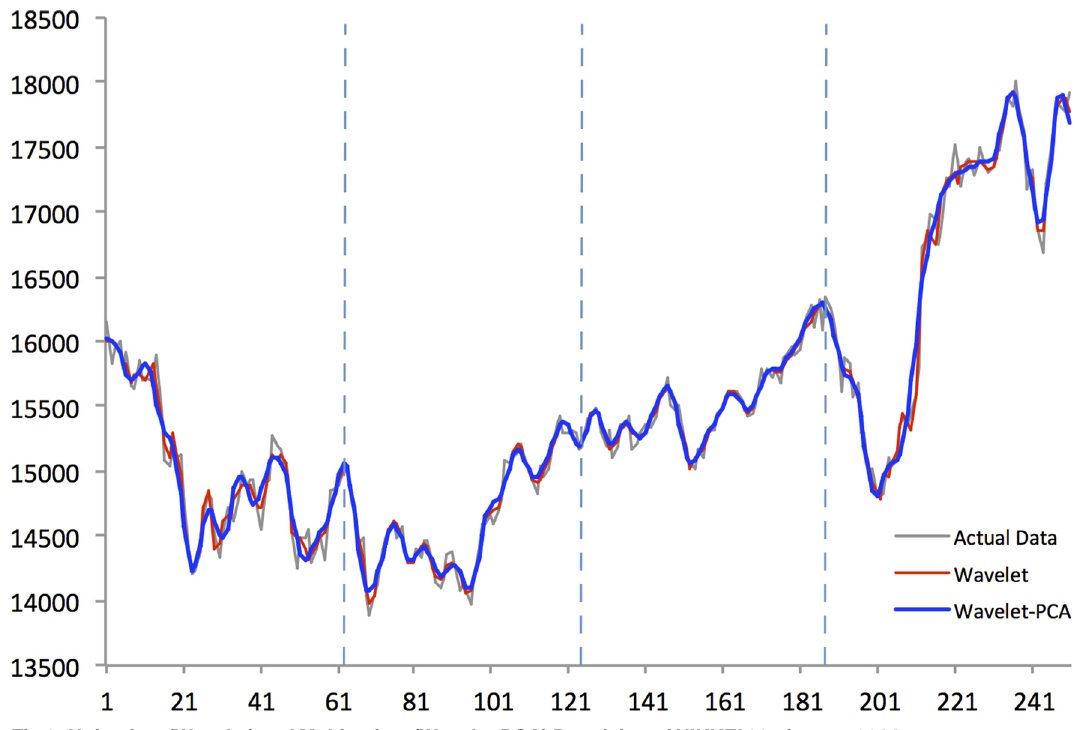
Fig 6. Univariate (Wavelet) and Multivariate (Wavelet-PCA) Denoising of NIKKEI 225 futures 2014.